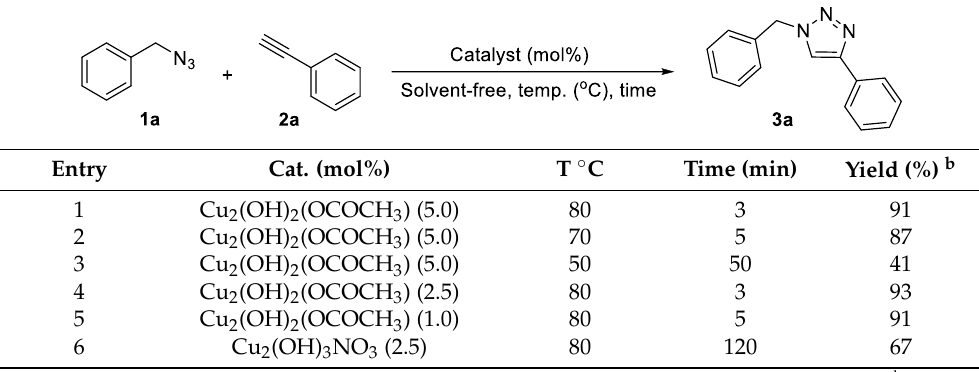
Table 4. Synthesis of Cu 2 (OH) 2 (OCOCH 3 )-catalyzed 1,4-disubstituted-1,2,3-triazoles a